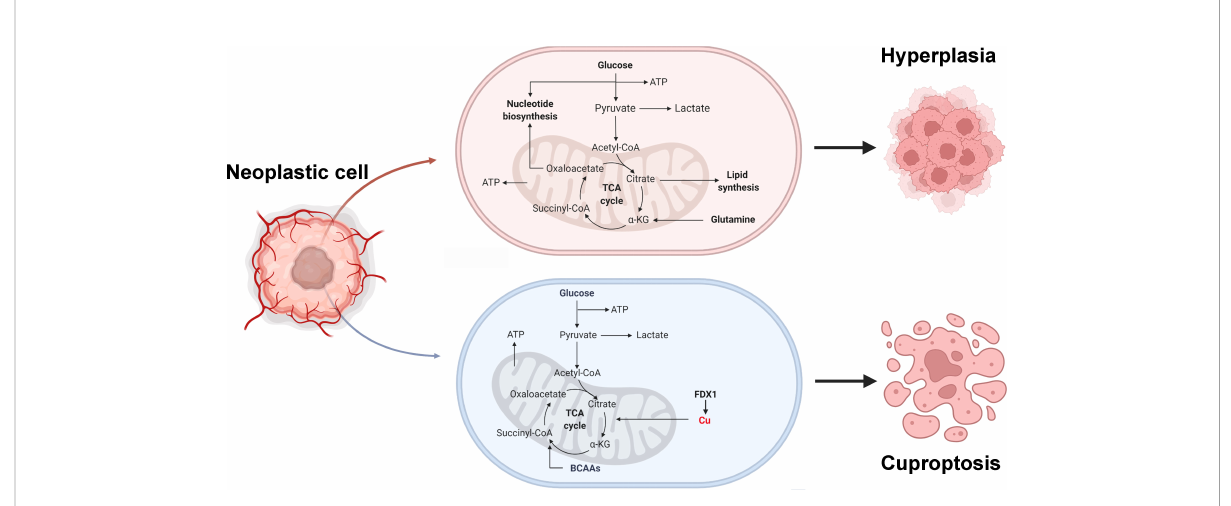
FIGURE 8 Tumor metabolism and cuproptosis mechanism. BCAAs: Branched-chain amino